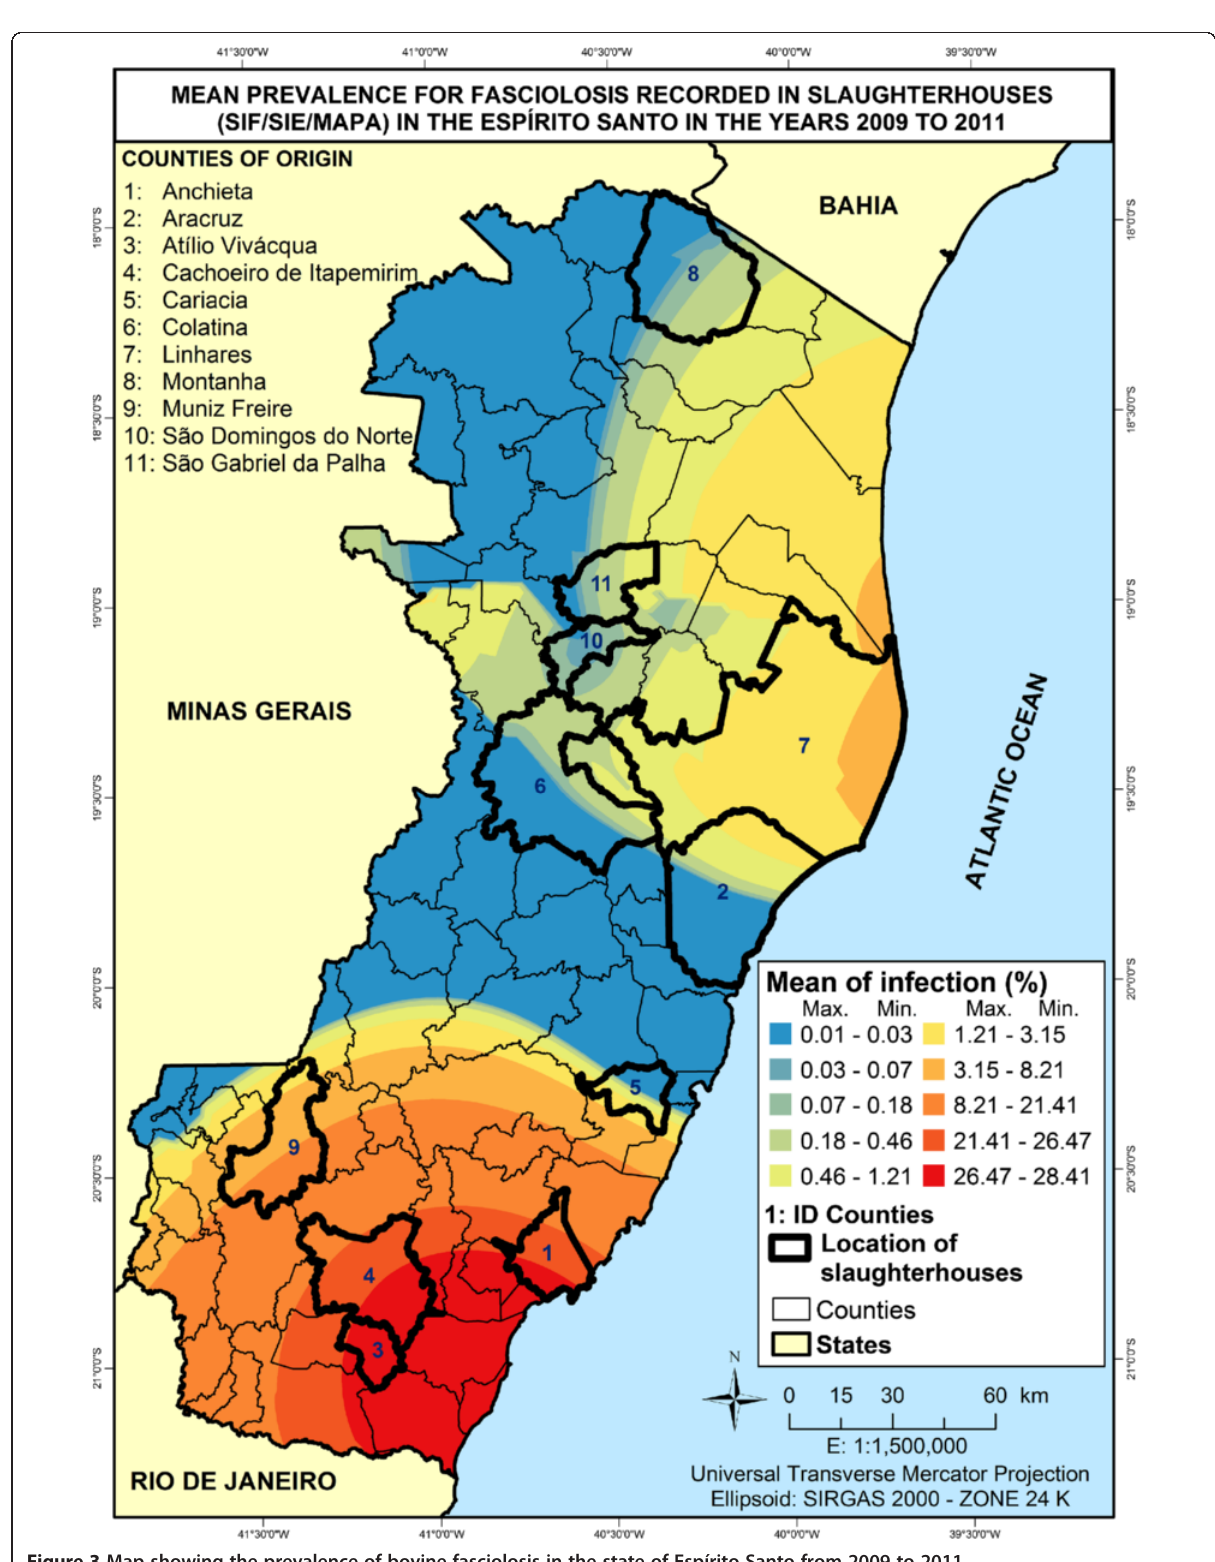
Figure 3 Map showing the prevalence of bovine fasciolosis in the state of Espírito Santo from 2009 to